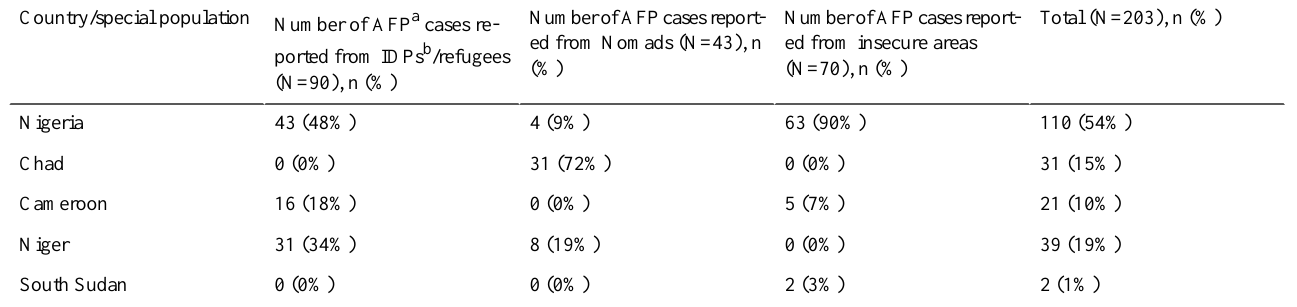
Table 5. Acute flaccid paralysis reported through Auto-Visual Acute Flaccid Paralysis Detection and Reporting (AVADAR) in special population settings (August 1, 2017, to July 31,